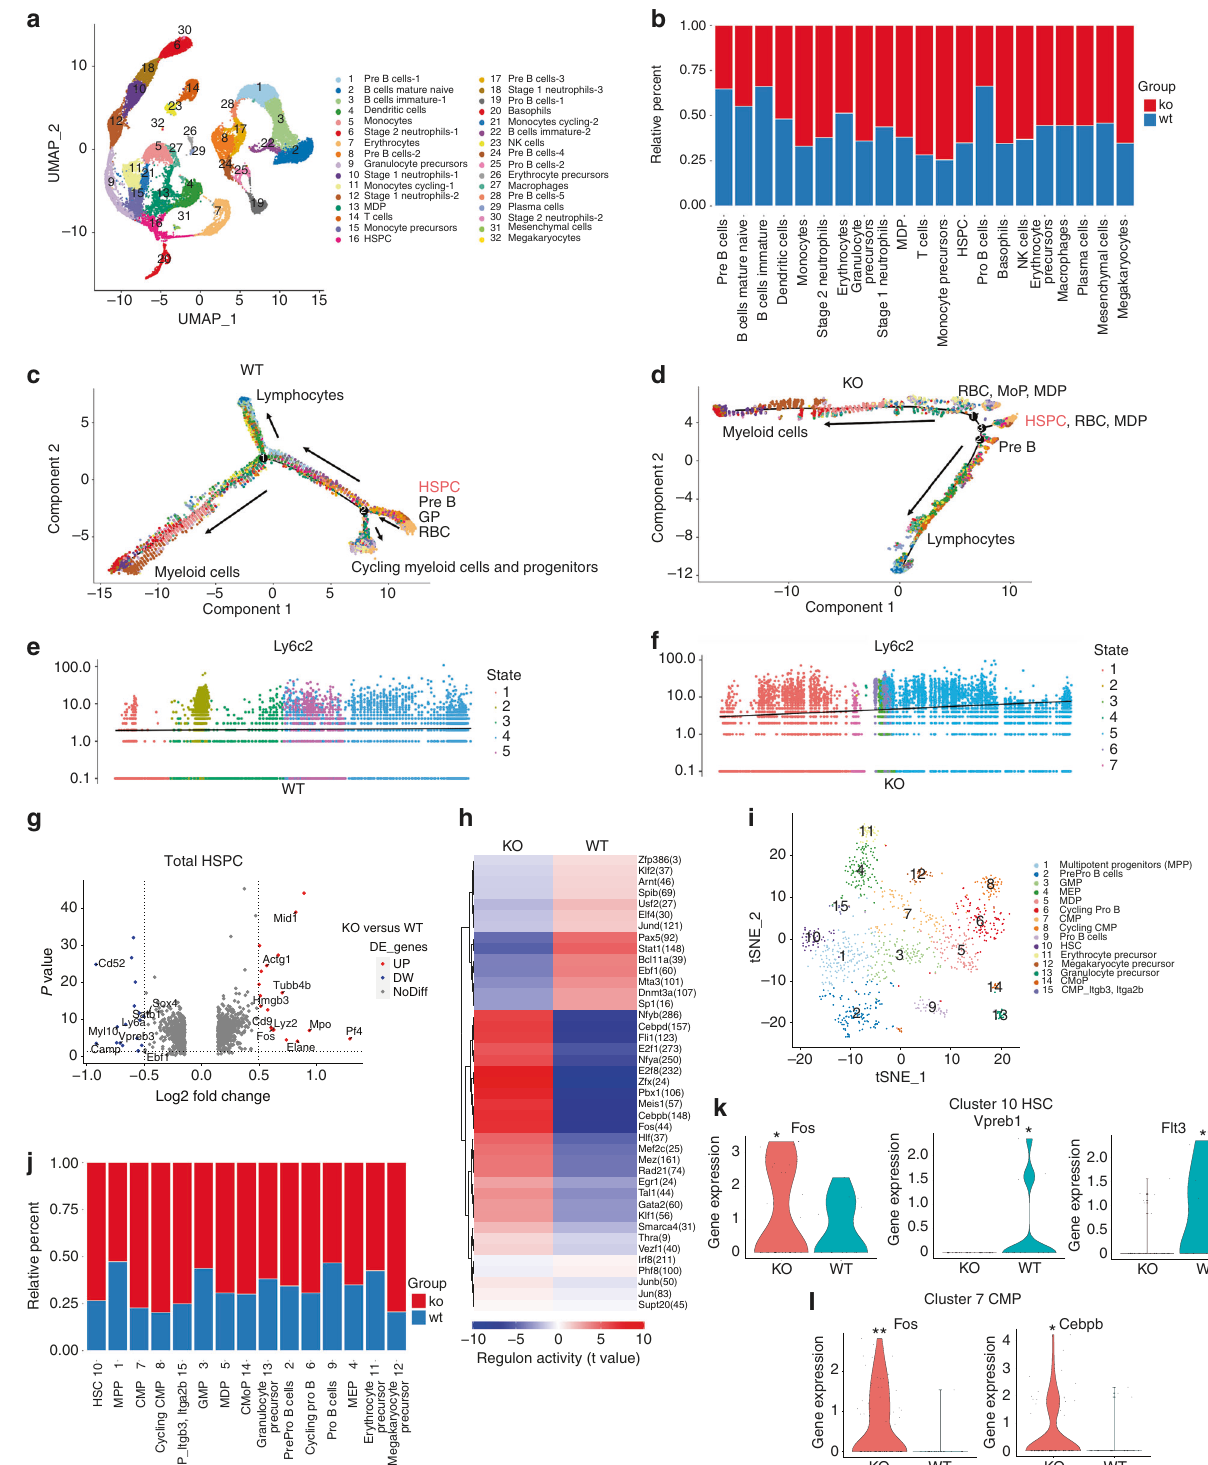
Fig. 5 Single cell RNA sequencing reveals myeloid-biased hematopoiesis in the bone marrow of TLR9 − / − mice. a scRNA-seq of BMNCs from TLR9 − / − (KO) and wildtype (WT) mice. UMAP clustering of 36263 single-cell transcriptomes colored by signi fi cant cell-type clusters. b Proportions of KO and WT cells in each cell type. Clusters of the same cell types were combined for analysis. c , d Monocle trajectories of WT ( c ) and KO ( d ) cells colored by cluster as in a . Expression of monocyte marker Ly6c2 along pseudotime (from left to right) within the WT ( e ) and KO ( f ) bone marrow cells. g – l Mapping of HSPCs. g The differentially expressed genes (DEGs) between KO and WT cells within total HSPCs (DEGs with Log 2 [fold change] > 0.5 and P value < 0.05 were considered signi fi cant). Red dots, upregulated genes in TLR9 − / − cells; blue dots, downregulated genes in TLR9 − / − cells. h SCENIC analysis revealed differences of speci fi c regulons activities between KO and WT cells in the entire HSPCs. i The reclustered HSPCs (cluster 16 in a ). j Proportions of KO and WT cells in each subcluster. X axis represents cluster number and cell type. k Differential expressions of Fos, Vpreb1 and Flt3 in HSC (cluster 10 in i ). l Expressions of Cebpb and Fos in CMP (cluster 7 in i ). Statistical signi fi cance was determined using Wilcoxon test; * P < 0.05 and ** P <